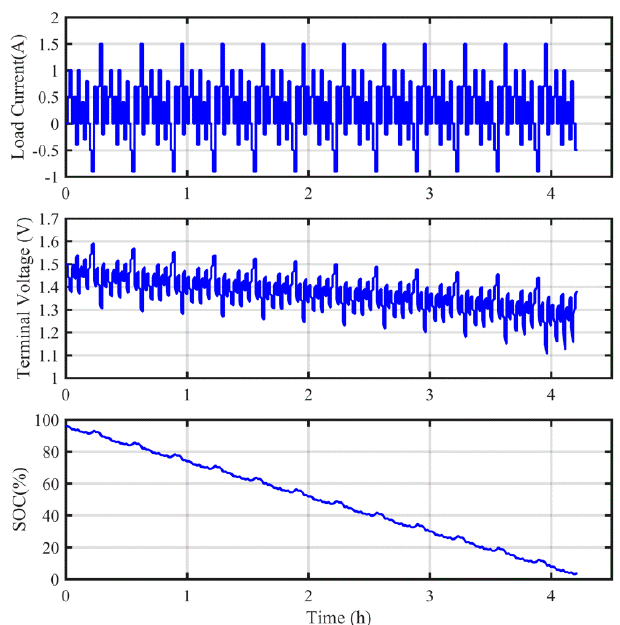
Figure 2. Measured load current, terminal voltage and calibrated state of charge (SOC) of the hybrid pulse experiment.